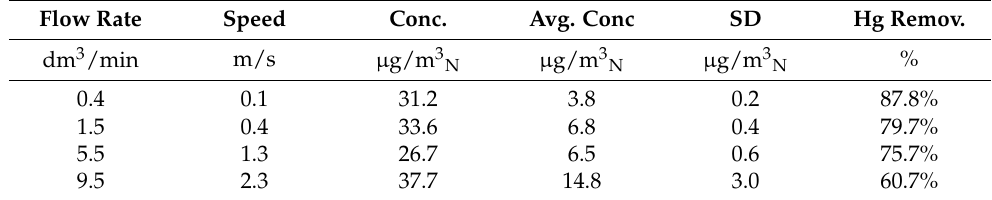
Table 8. The results of the determination of Hg in the flue gas after passing through the module (120 ◦ C).